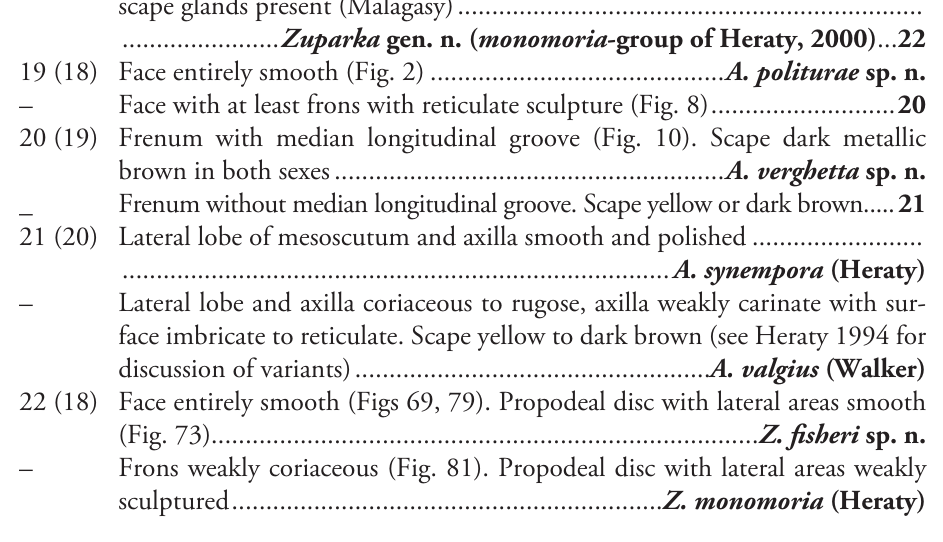
Etymology. Random combination of letters and referring to the distribution; gen- der feminine. Discussion. Defined by Heraty (1994) as the Orasema valgius group for two